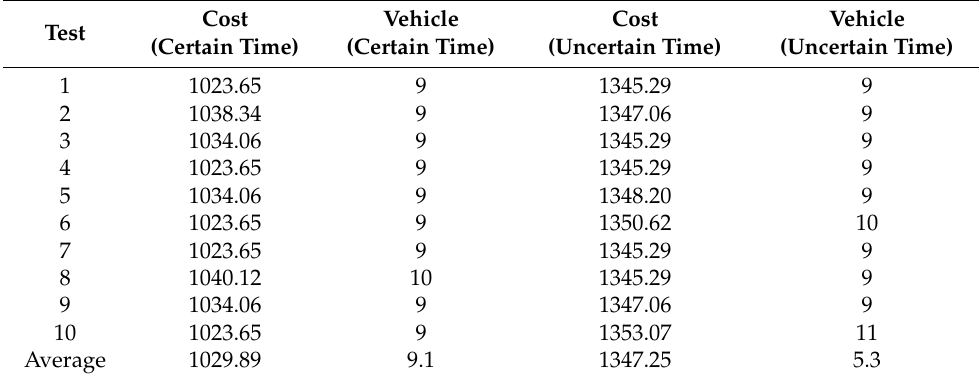
Table 7. Comparison of scheme Costs for RC101.